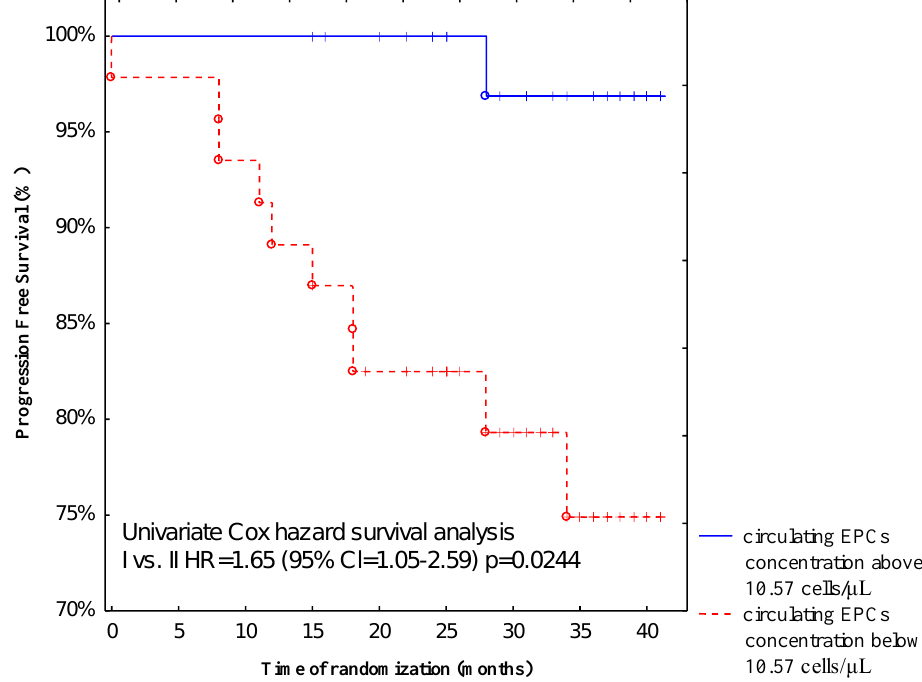
Figure 4. Kaplan–Meier curve for the progression-free survival (PSF) analysis of the entire population with IBrC according to pre-treatment circulating EPC numbers, which were determined with the immune-phenotype CD45 − CD34 + CD133 + CD31 + by flow cytometry. Cut-o ff values between low 0–10.57 cells / µ L (red line) and high > 10.57 cells / µ L (blue line) pre-treatment circulating EPC numbers were established. The cut-o ff value of circulating EPCs count was established at 10.57 cells / µ L, due to our previous findings, where we noted that the median value of circulating EPCs was 10.57 cells / µ L in breast cancer patients as compared to healthy postmenopausal women as well as according to receiver-operating curve (ROC) analysis [9].